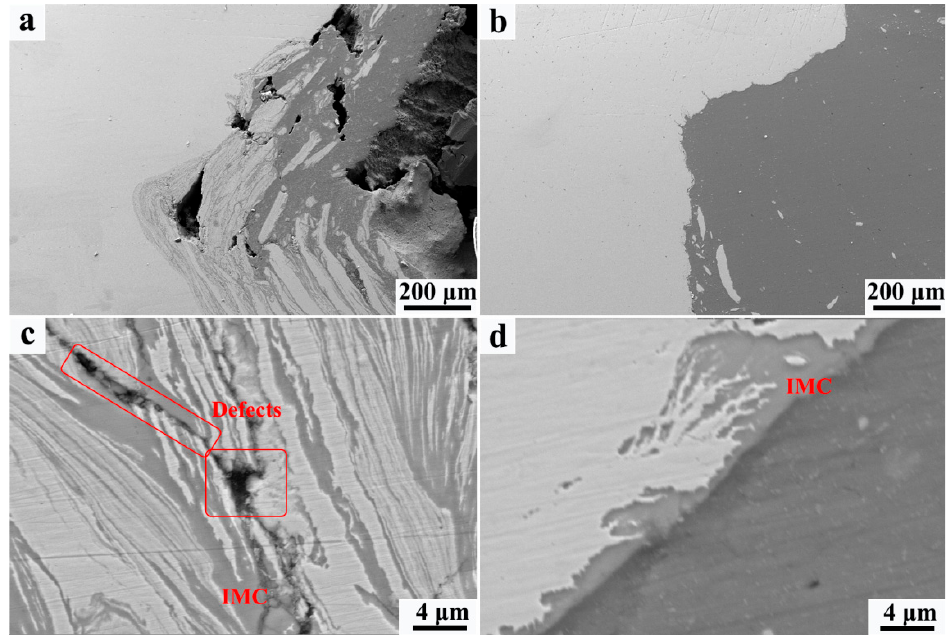
Figure 4. Low-magnification SEM of Al/steel interface in the ( a ) FSW and ( b ) UaFSW joint; the morphology of IMCs layer in the ( c ) FSW and ( d ) UaFSW joint.